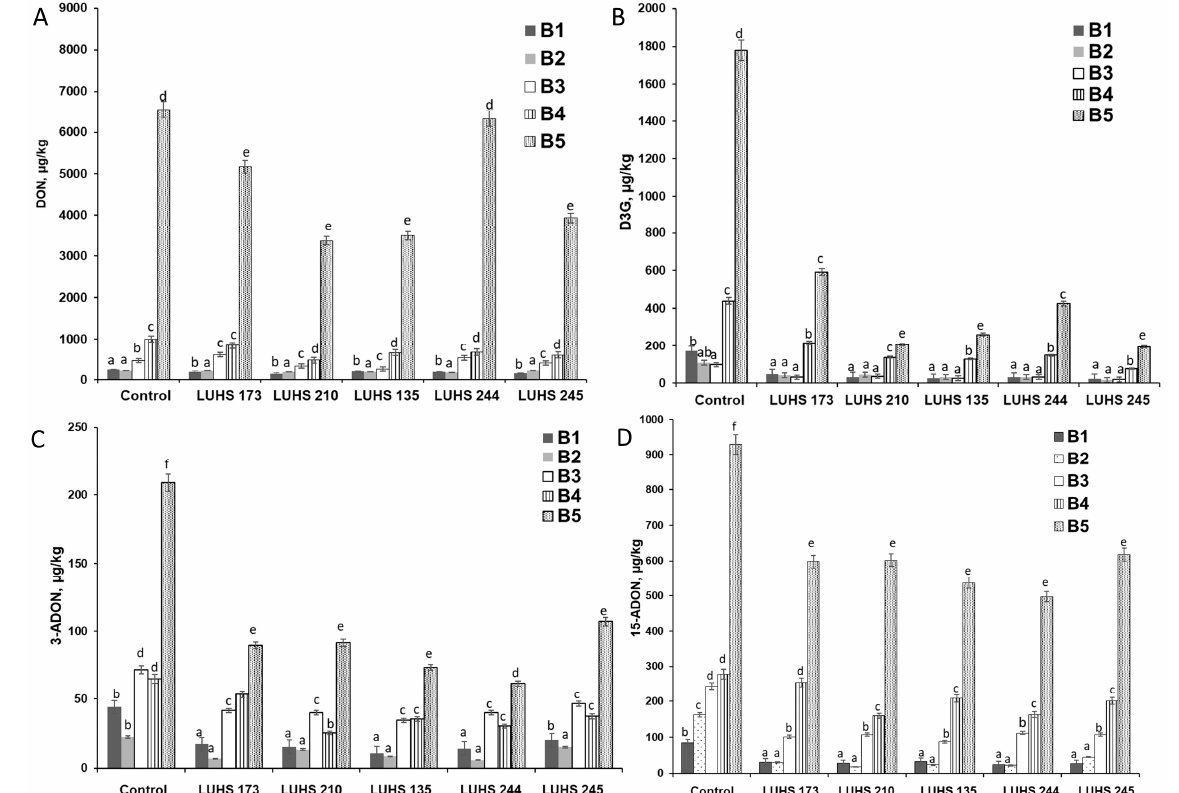
Figure 1. Changes in concentrations of DON ( A ) and DON conjugates [D3G ( B ), 3 –ADON ( C ), and 15-ADON ( D )] during fermentation in barley wholemeal product samples (BWP1–BWP5) with different contamination using different LAB strains ( Levilactobacillus brevis LUHS173, Lacticaseibacillus casei LUHS210, Lactiplantibacillus plantarum LUHS135, Lacticaseibacillus paracasei LUHS244, and Liquorilactobacillus uvarum LUHS245). DON—deoxynivalenol; D3G—deoxynivalenol-3-glucoside; 3-ADON-3-acetyldeoxynivalenol and 15-ADON-15-acetyldeoxynivalenol. a–f Mean values denoted with different letters indicate significantly different values between the columns ( p ≤ 0.05).